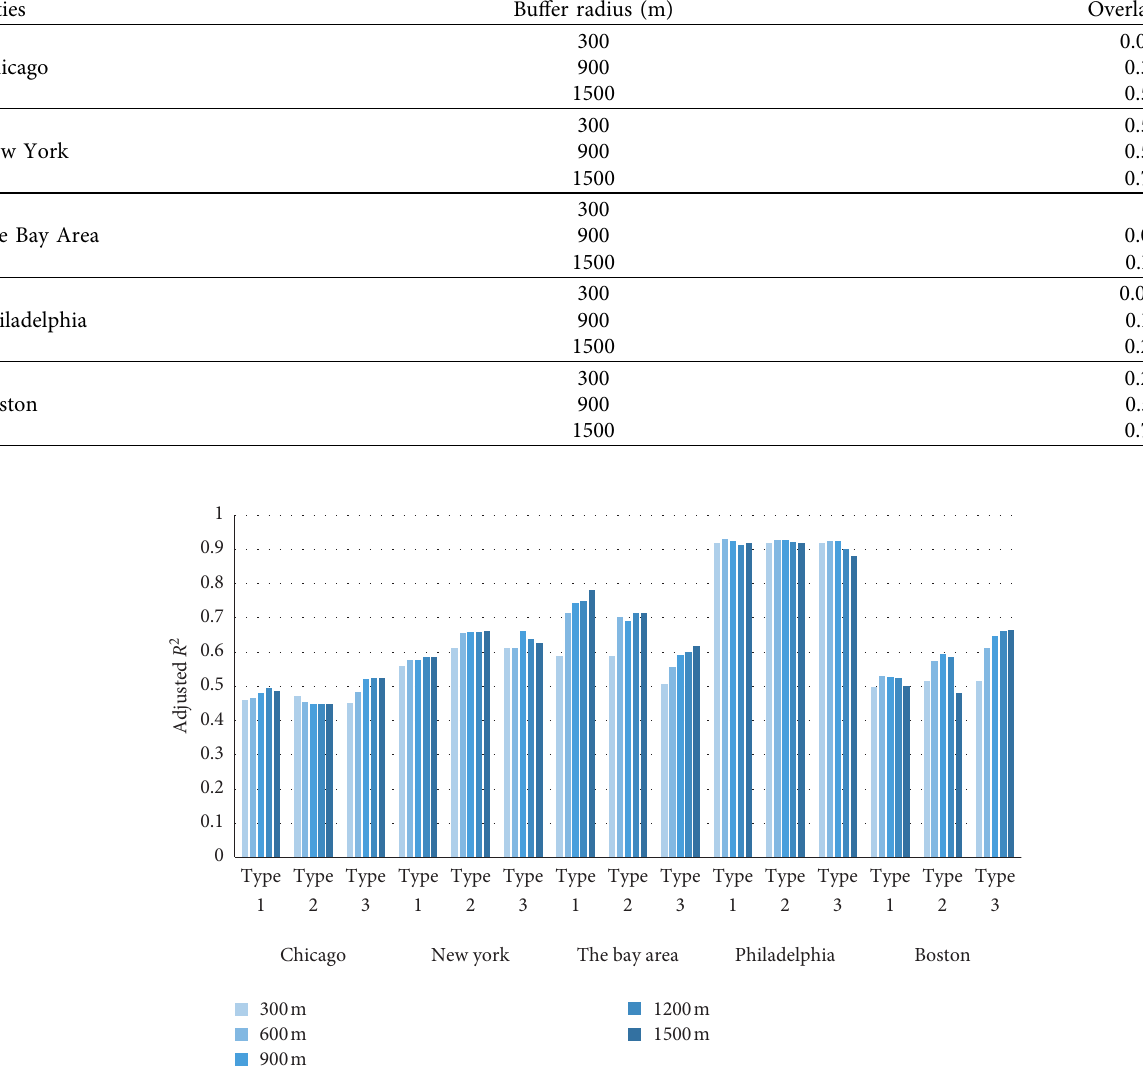
Table 4: Overlap ratio of buffer area in each city.